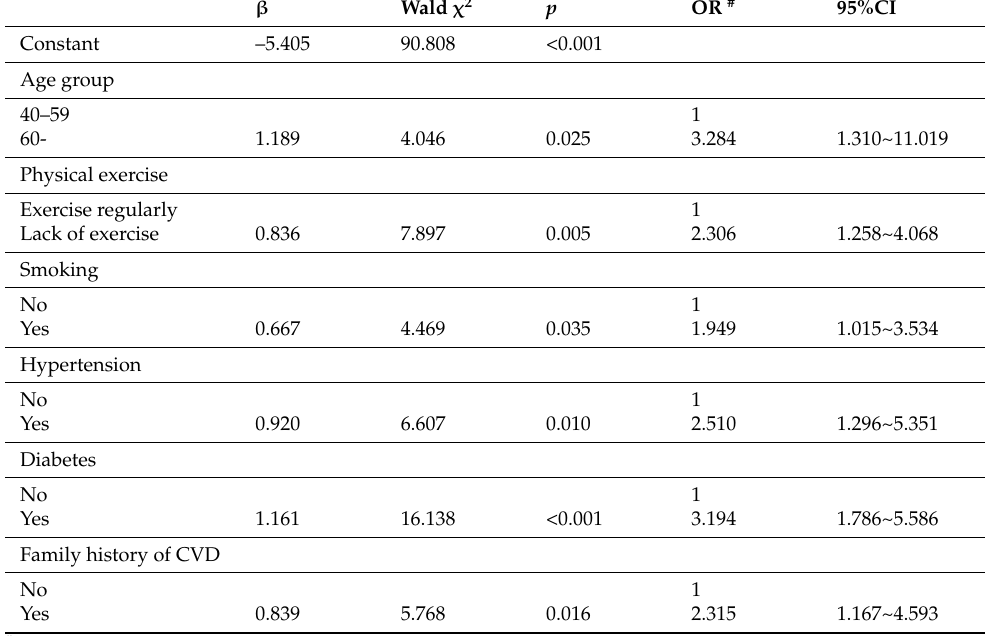
Table 4. The risk factors of cerebrovascular